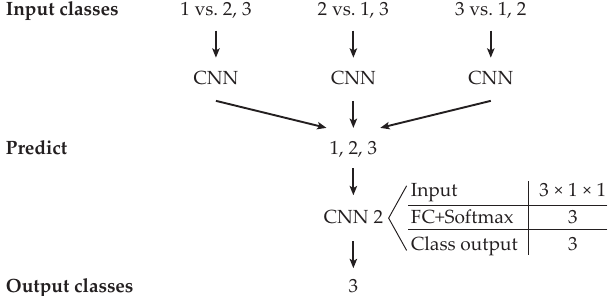
Figure 15. Process of the vehicle classification of overpassing vehicles.